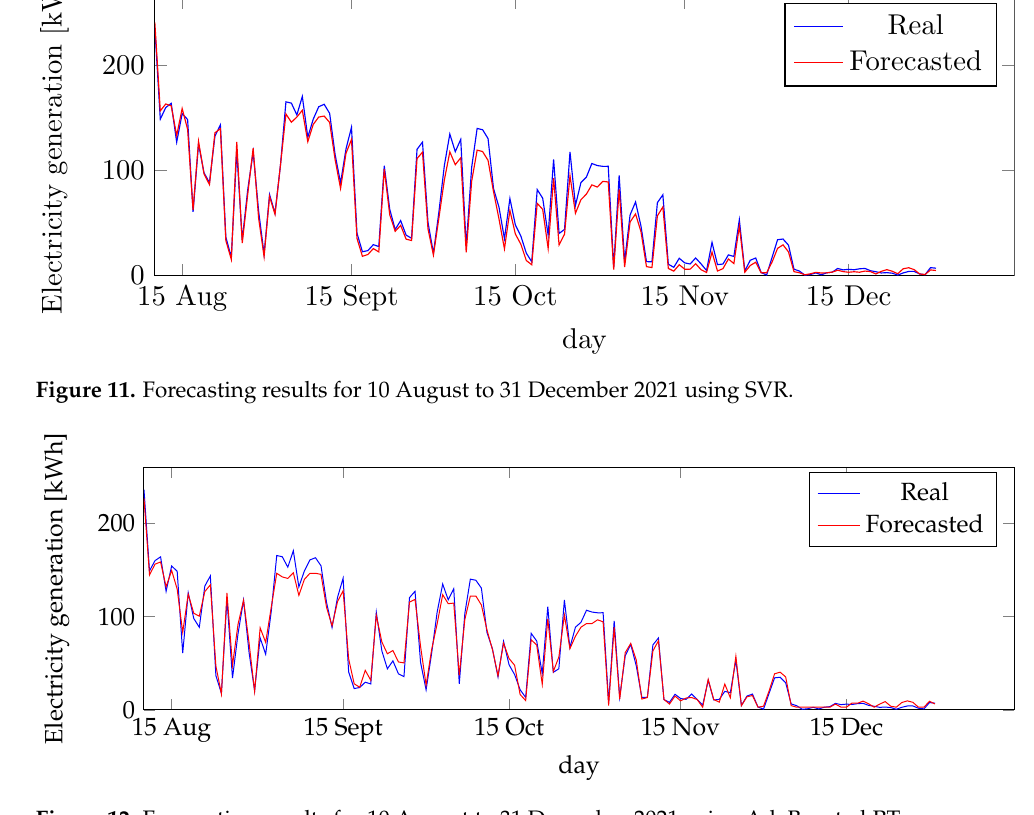
Figure 12. Forecasting results for 10 August to 31 December 2021 using AdaBoosted